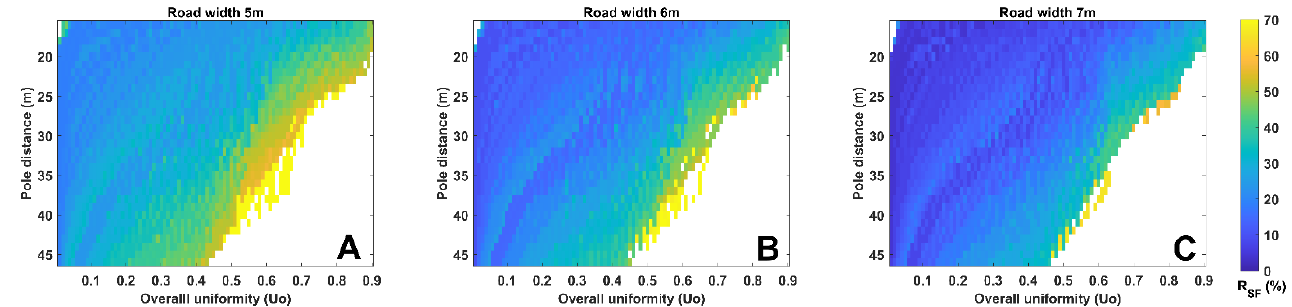
Figure 16. Overall uniformity of illuminance vs. pole distance vs. minimum spill flux ratio. Dark blue indicates a low percentage of spill luminous flux, whereas yellowish refers to a higher percentage of spill luminous flux levels. The white space equals a lack of technical solutions: ( A ) results for road width of 5 m; ( B ) results for road width of 6 m; ( C ) results for road width of 7 m.